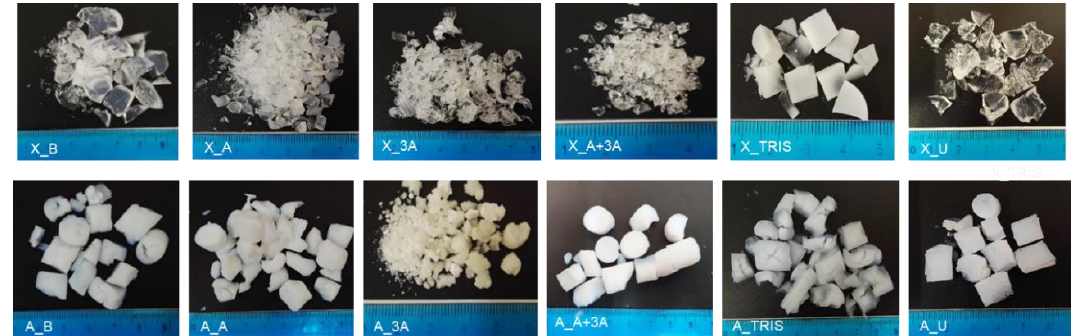
Figure 1. Photographs of the prepared functional aerogel and xerogel adsorbents.